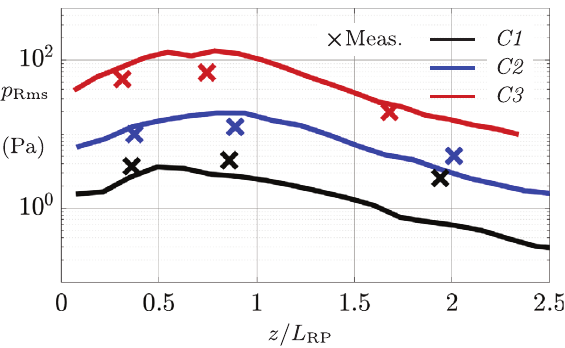
~ Q ic for case C 1. LH ; SGS